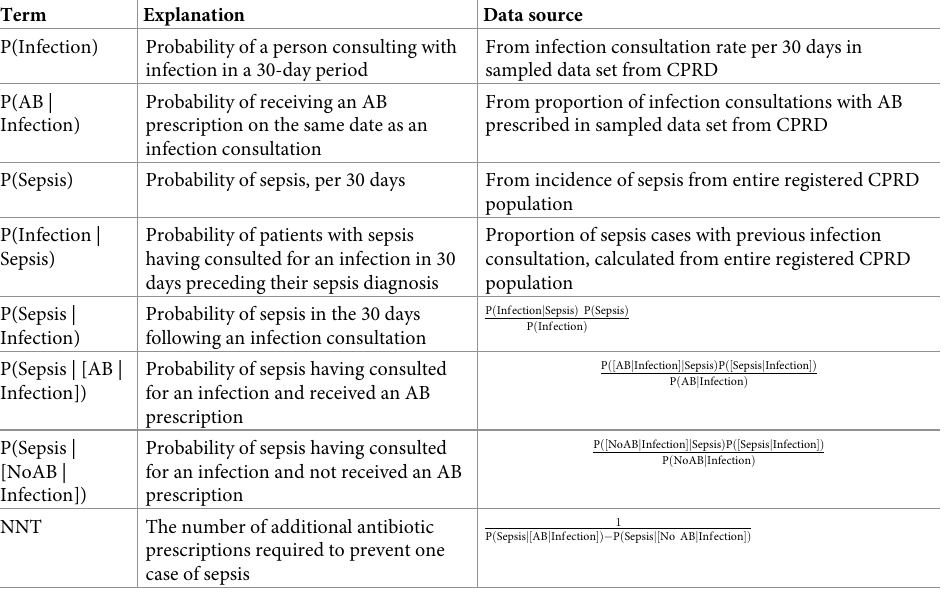
Table 1. Definition and data source for